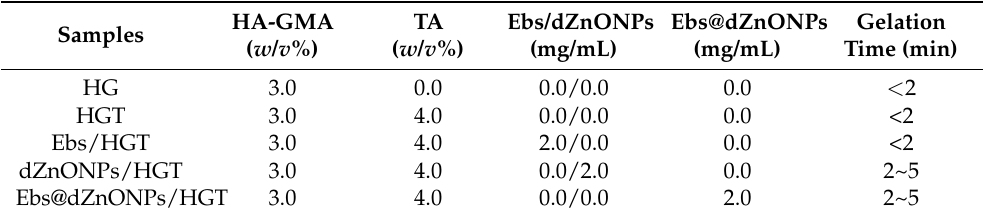
Table 1. The preparation parameters of hydrogels for HG, HGT, Ebs/HGT, dZnONPs/HGT